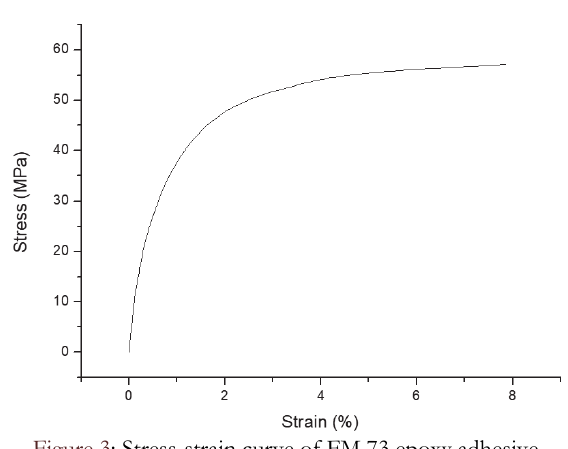
Figure 3: Stress-strain curve of FM 73 epoxy